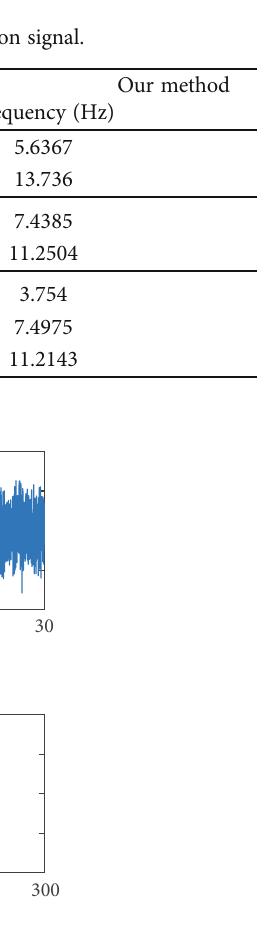
Figure 13: Time series and PSD of the horizontal tail in CH1.